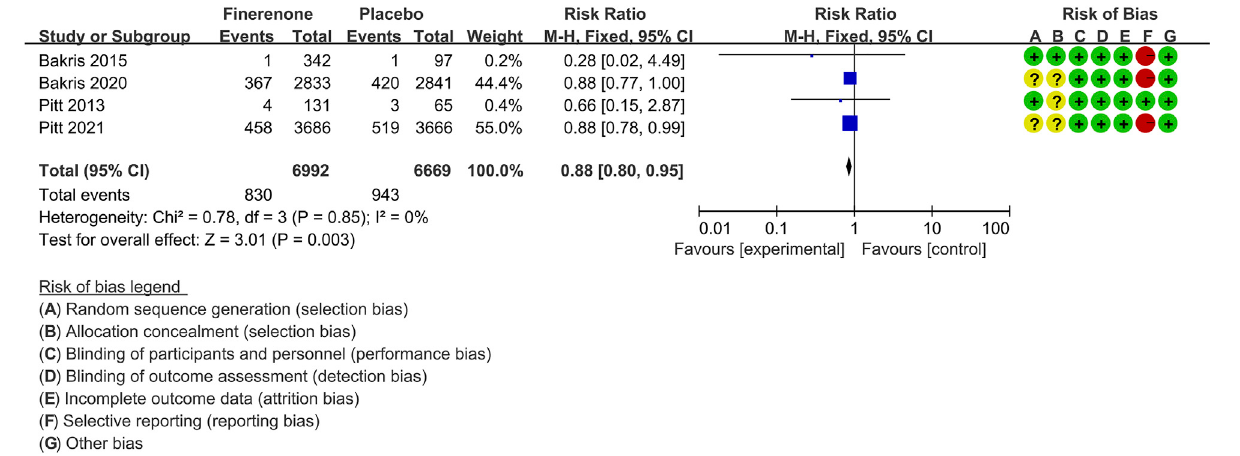
FIGURE 7 | Meta-analysis results of the effect of fi nerenone versus placebo on cardiovascular events.